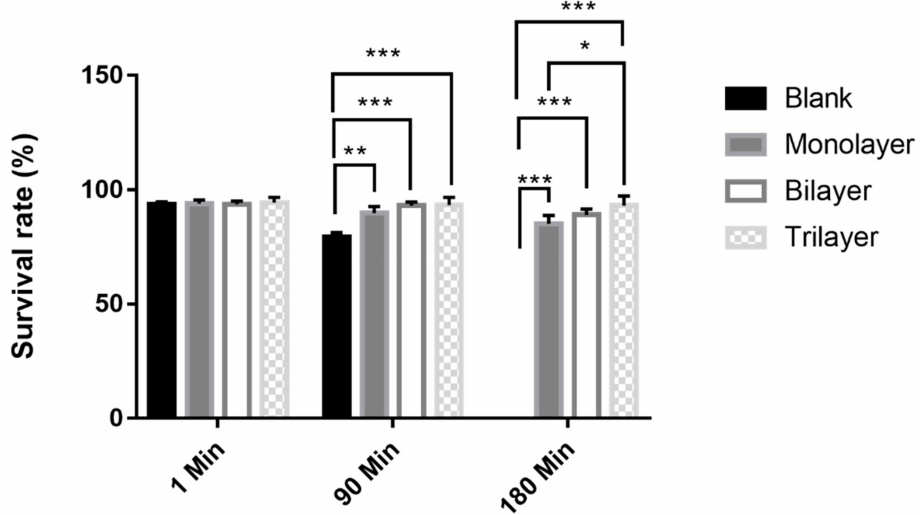
Figure 7. Survival rate of free and encapsulated L. casei K17 under simulated gastral environment for